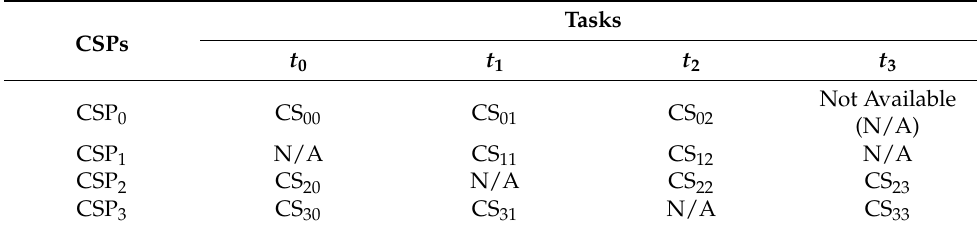
Table 1. The CSPs and their candidate CSs. CSPs